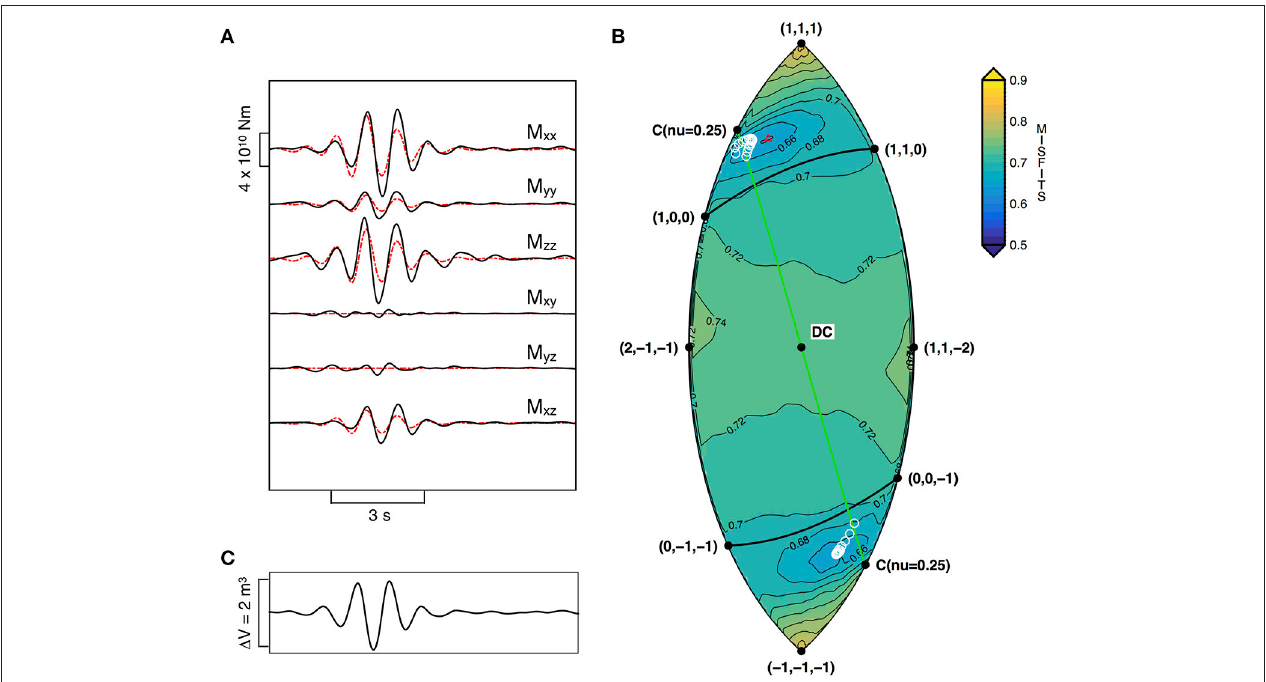
FIGURE 8 | (A) Source-time function from the MT unconstrained inversion (black line), and for the E 2 min solution from the constrained inversion (dashed red line). (B) Misfit by fixed moment-tensor solution, plotted together with the γ - δ distribution for the unconstrained inversion (white circles), and with the γ - δ pair for the constrained inversion (red triangle). (C) Estimated volume change for the source-time function of the MT